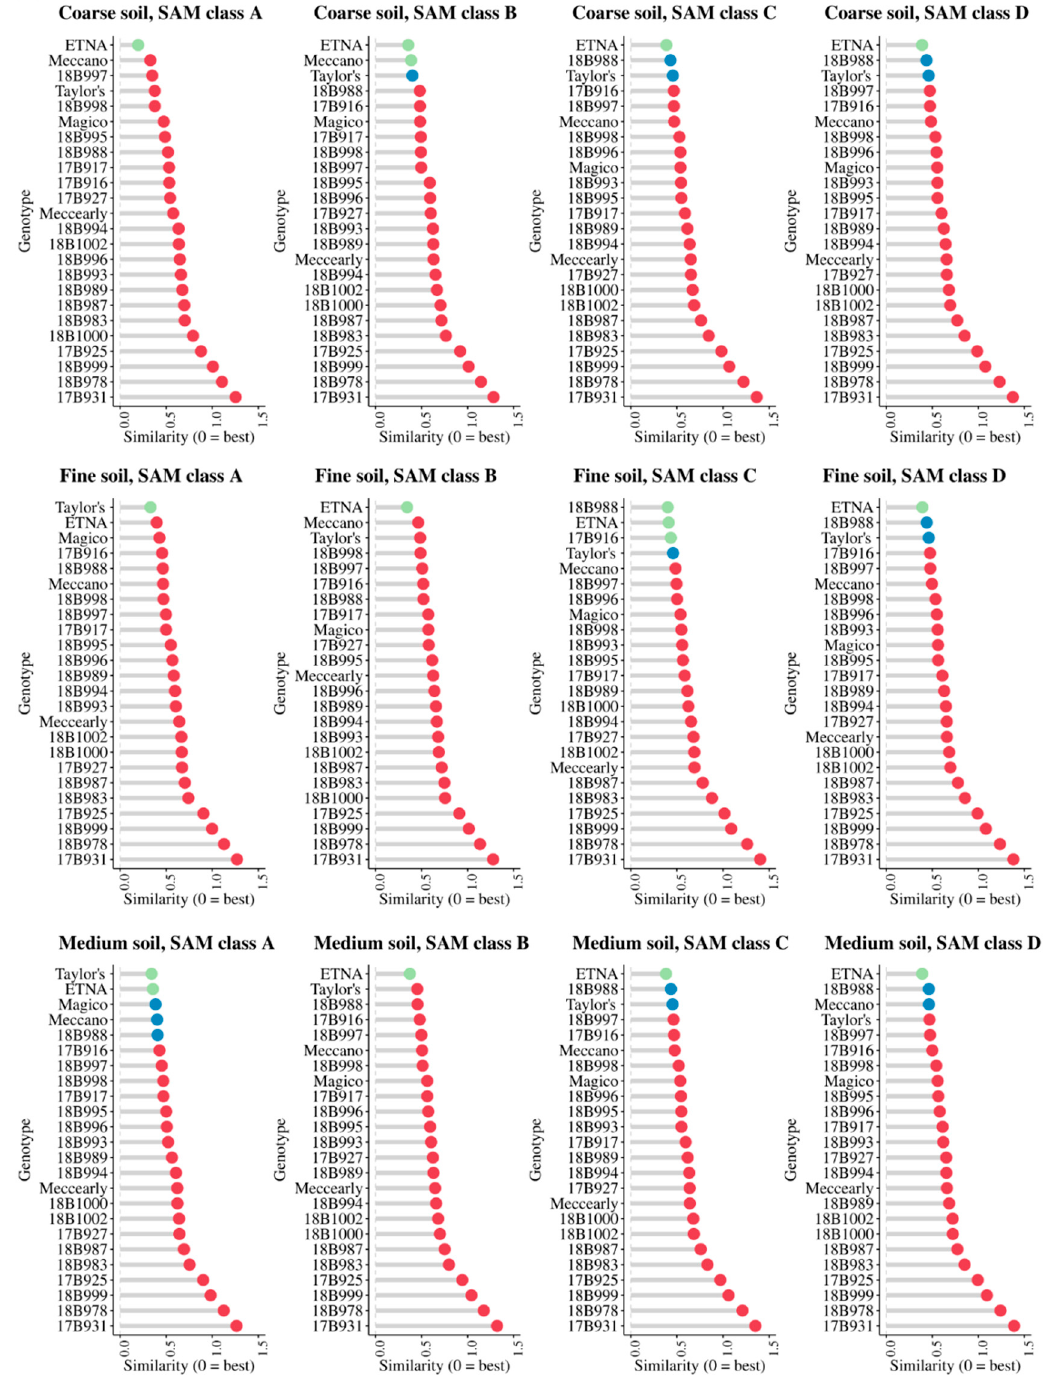
Figure 6. Similarity indices for late sowings between the ideotypes defined for the different agro-climatic contexts and the functional trait profiles of the 24 varieties analyzed in this study. Green dots: varieties recommendable (difference in similarity index lower than 10% compared to the most similar to the ideotype); blue dots: second-choice varieties (difference in similarity index between 10% and 20%); red dots: varieties less suitable (difference in similarity index larger than 20%).